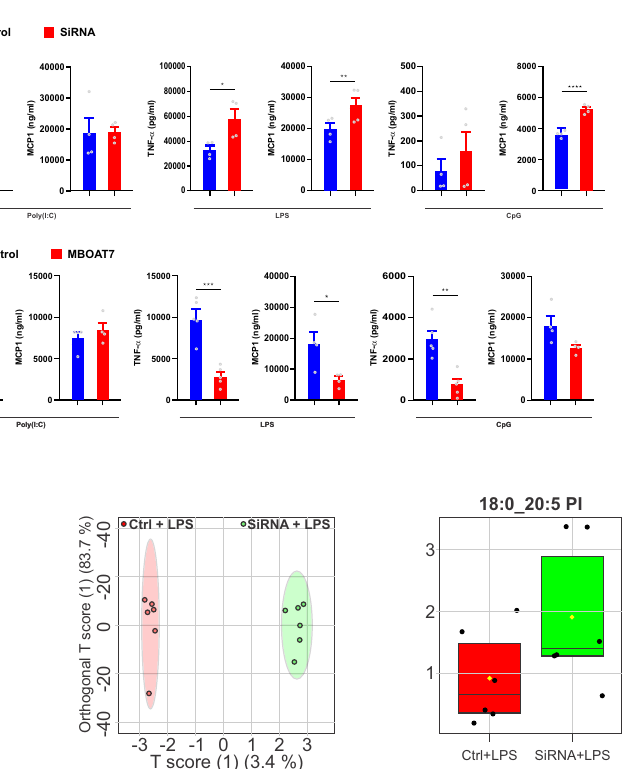
Statisticaldifferencesbetweengroupswereassessedby2-tailedStudent ’